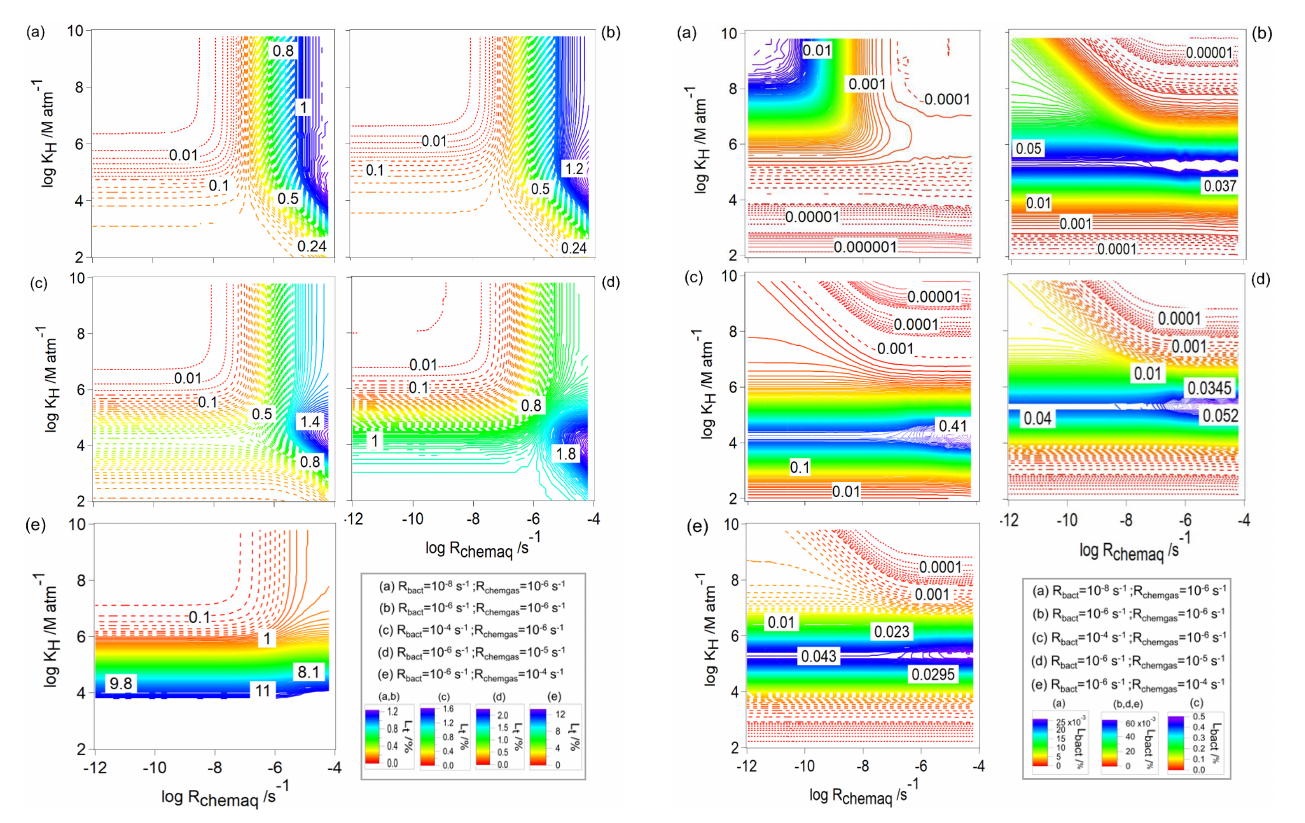
Figure 6. The total loss of water-soluble organic gases ( L t , Eq. 10) as a function of R chemaq and K H . All figure panels have the same scales on the ordinates and abscissas. The simulations were per- formed for constant values of R bact and R chemgas ; their values are indicated in the box at the bottom right.